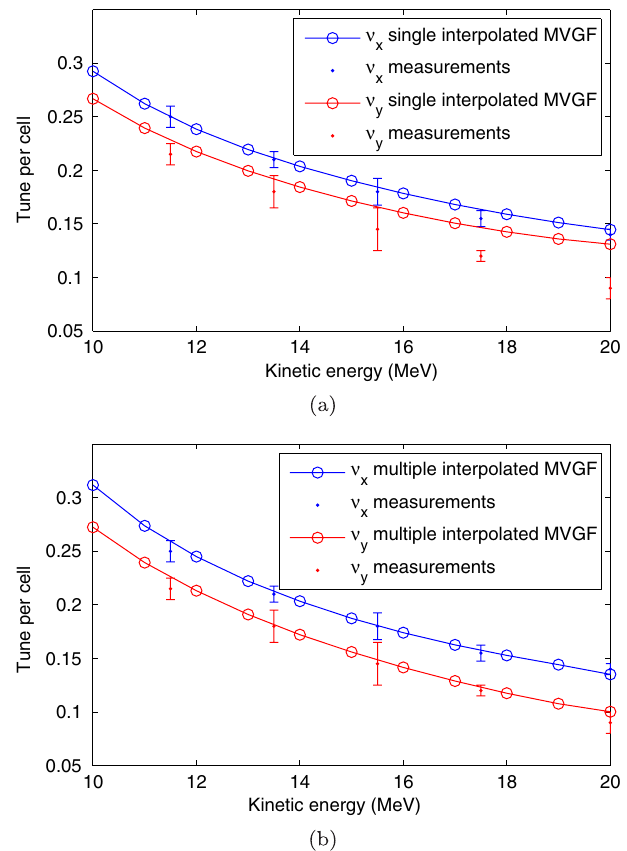
FIG. 17. Tunes per cell in the lattice S 1 (circles) are compared with the measured tunes from the lattice E 1 (points). In (a), the tunes in S 1 are obtained from a single transfer map (interpolated MVGF) with reference energy 14 MeV. There is a relatively good agreement for the horizontal tune (in blue) for energies smaller than 16 MeV. The simulated vertical tune (red) is significantly larger than the measurement, especially for large